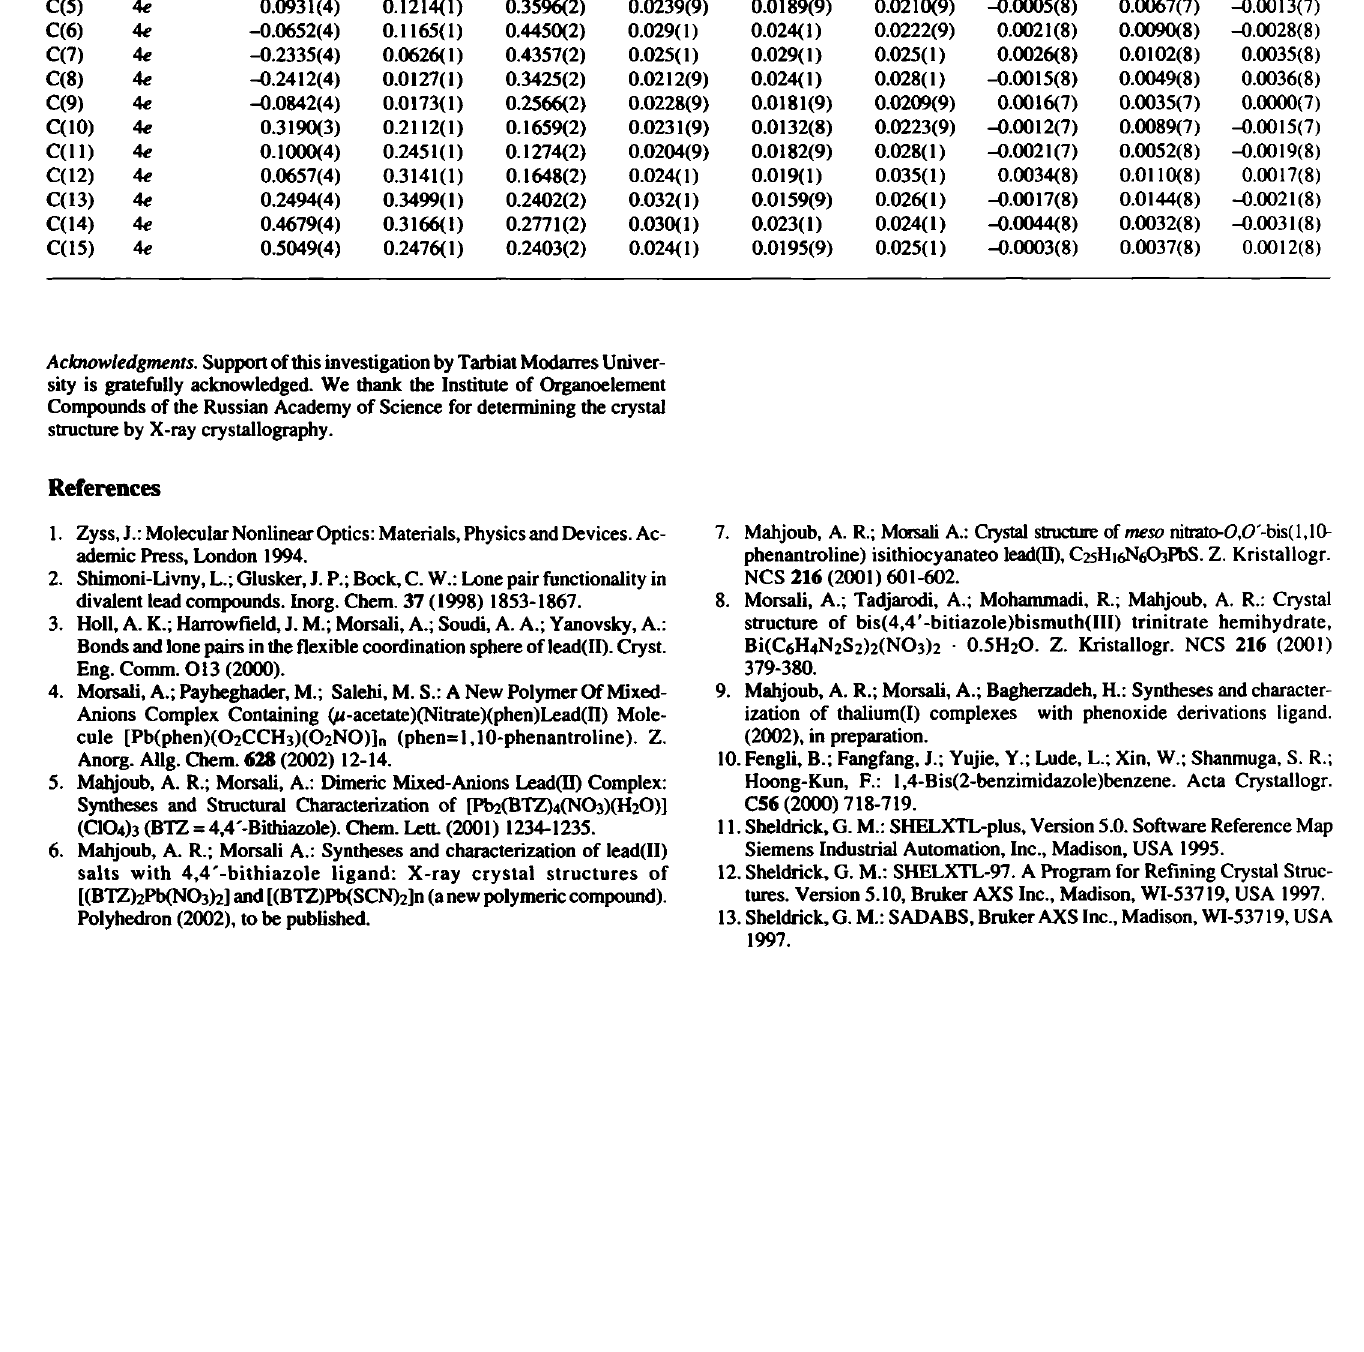
Table 3. Atomic coordinates and displacement parameters (in Â 2